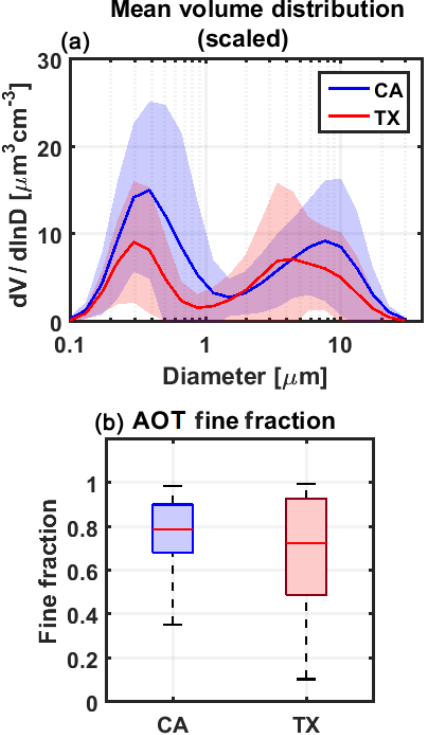
Figure 11. (a) Mean volume distribution retrieved from AERONET/DRAGON sun photometer measurements, scaled to a maximum aerosol layer height of 1km for CA and 3km for Texas. (b) Statistics for the AERONET/DRAGON aerosol optical depth fine